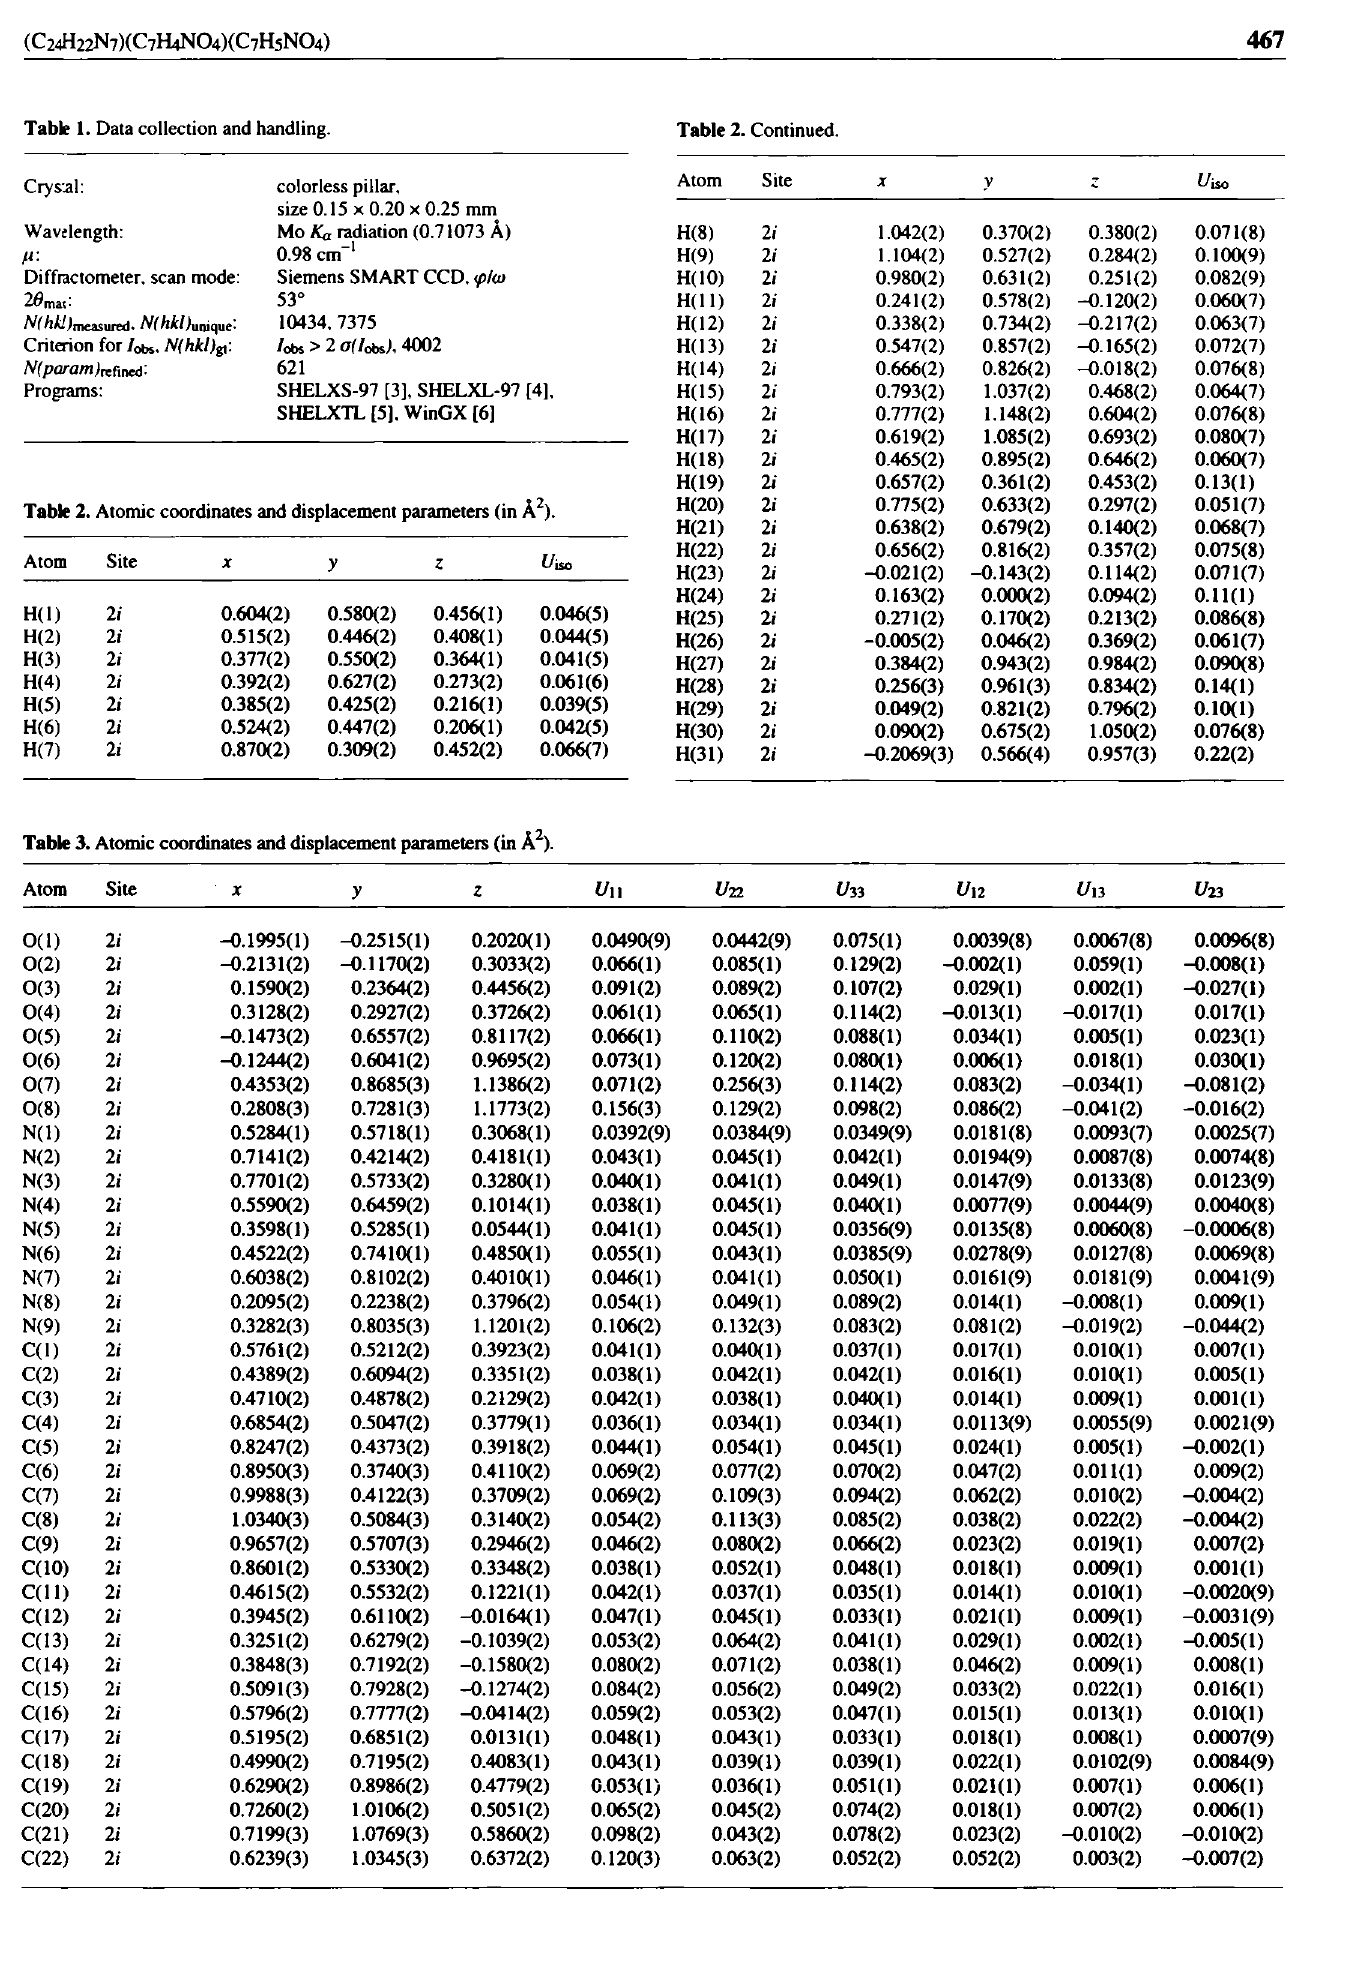
Table 2. Atomic coordinates and displacement parameters (in A 2 ).